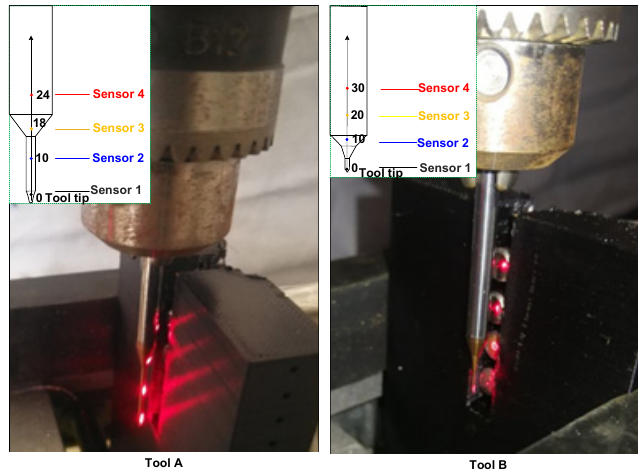
Figure 11. The relative position of sensor array and the tool.